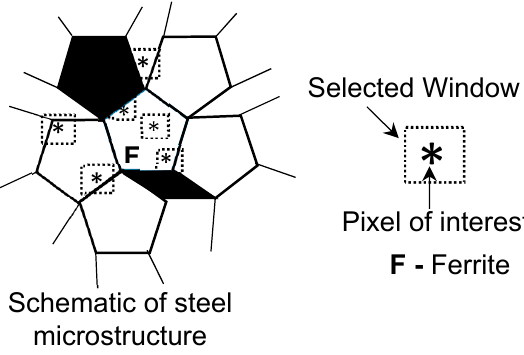
Figure 4. Schematic of pixel locations selected for extraction of textural features.